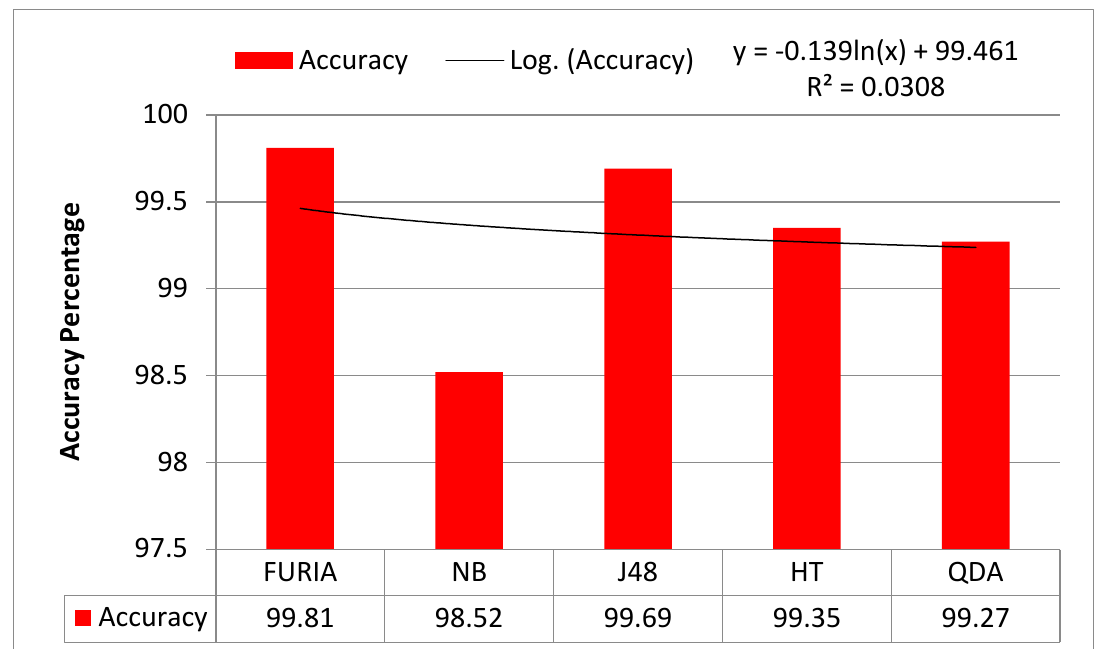
Figure 6. Accuracy analysis through each employed model.